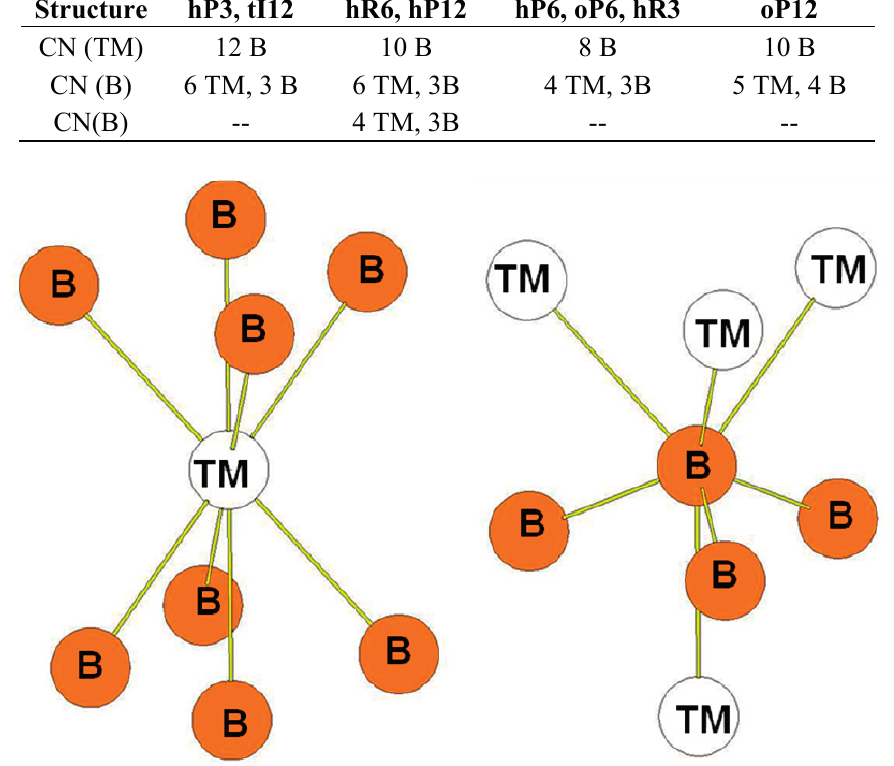
Figure 10. Environment of TM and B atoms in the hR3 (CaSi 2 -type)